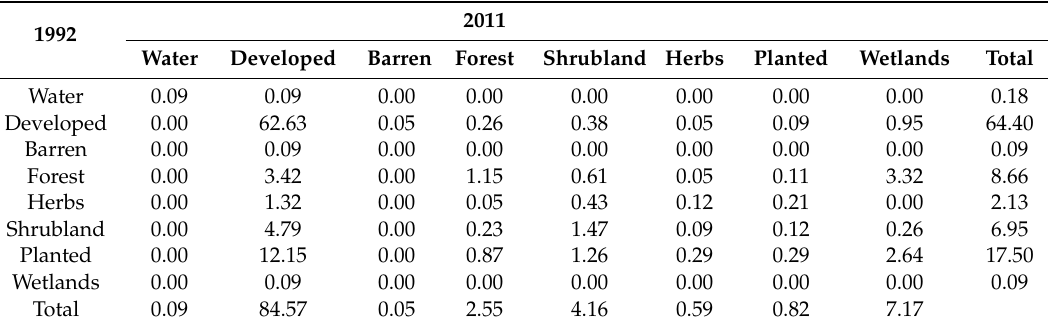
Table 7. Transition matrix (in percentages) of land use change in Walzem Creek from 1992 to 2011. 1992